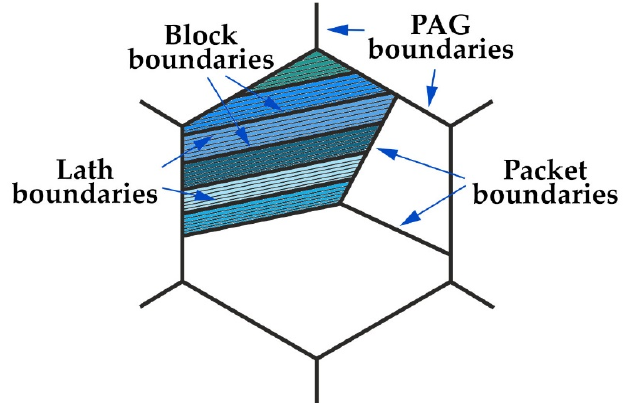
Figure 3. Scheme of lath martensitic